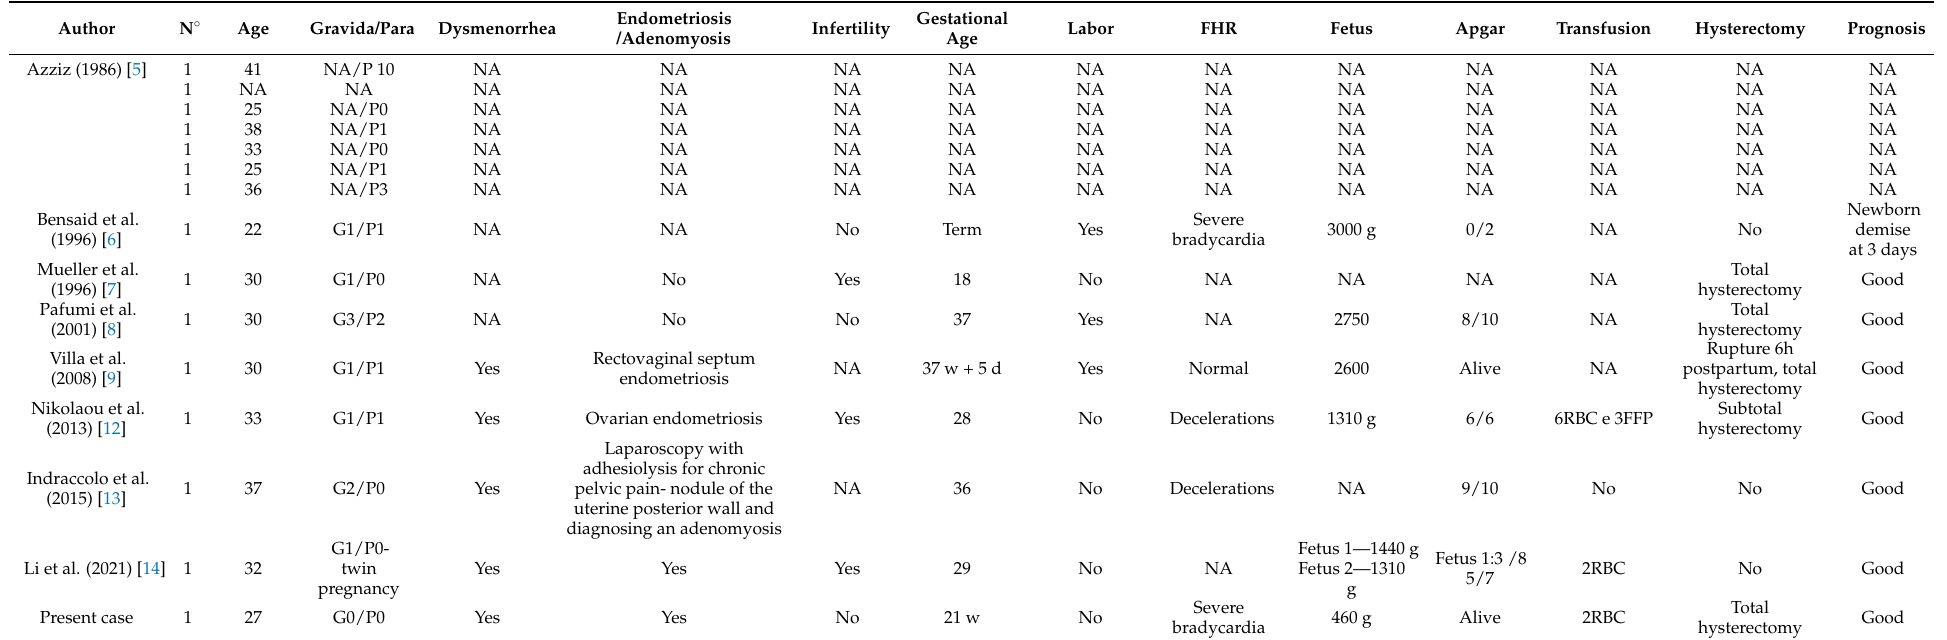
Table 1. Cases of spontaneous uterine rupture in pregnancy due to